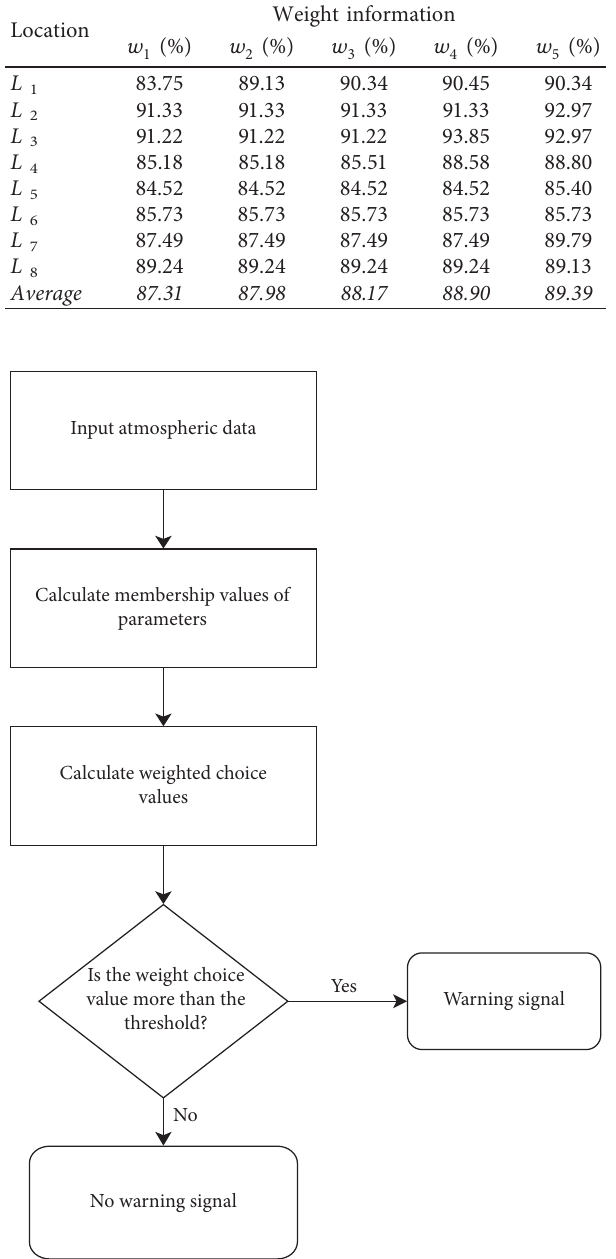
Algorithm 5. Identification of the most hazardous location